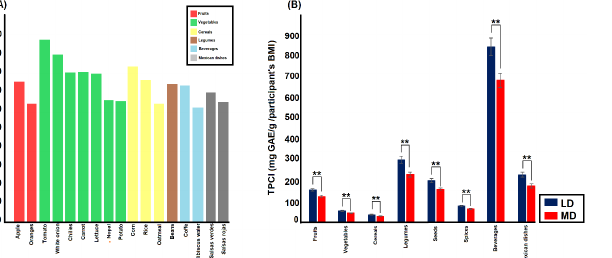
Figure 1. Bar graph ( A ) shows food more frequently consumed in this Mexican sample, while bar between LD and MD groups. ** p < 0.001 graph ( B ) illustrates differences in the total phenolic compounds intake (PCI) of all food groups between LD and MD groups. ** p <